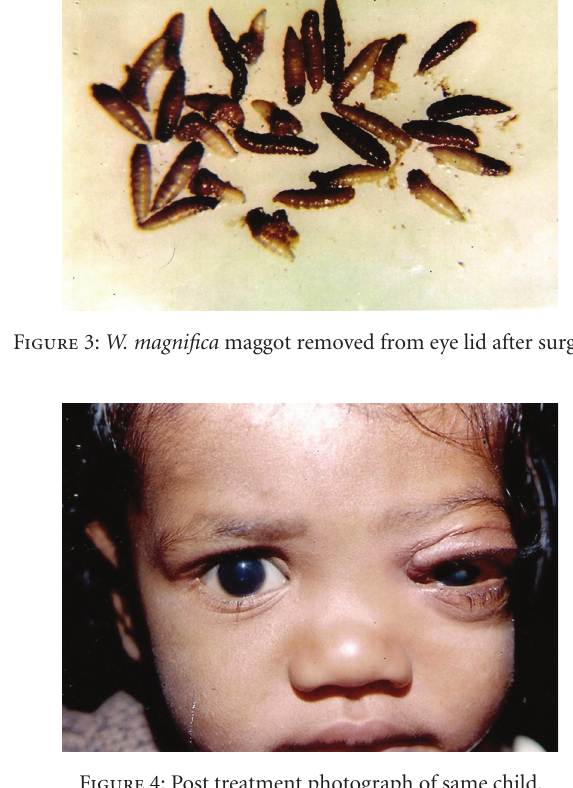
Figure 2: Pre treatment photograph showing chemosis and ulcer.